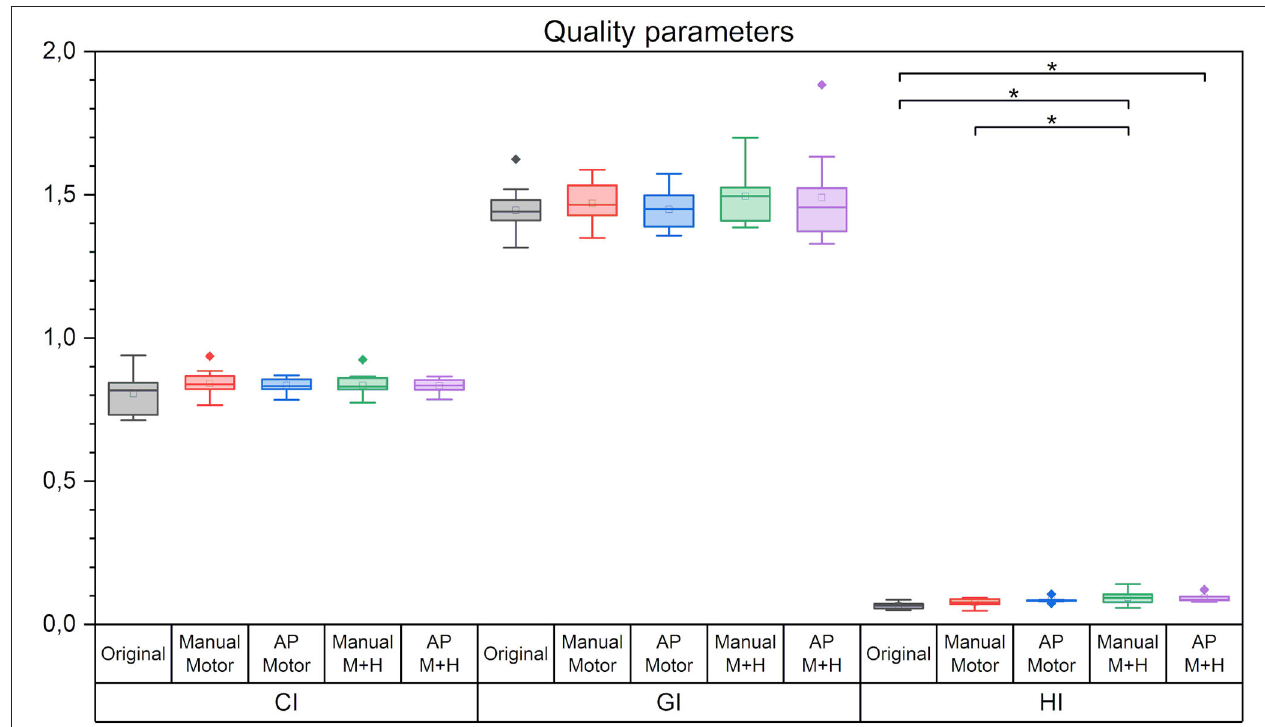
FIGURE 6 | Maximum and mean dose to the motor cortex. Line = median value, square = mean value, diamond = outliers, star = statistically significant at p < 0.005.